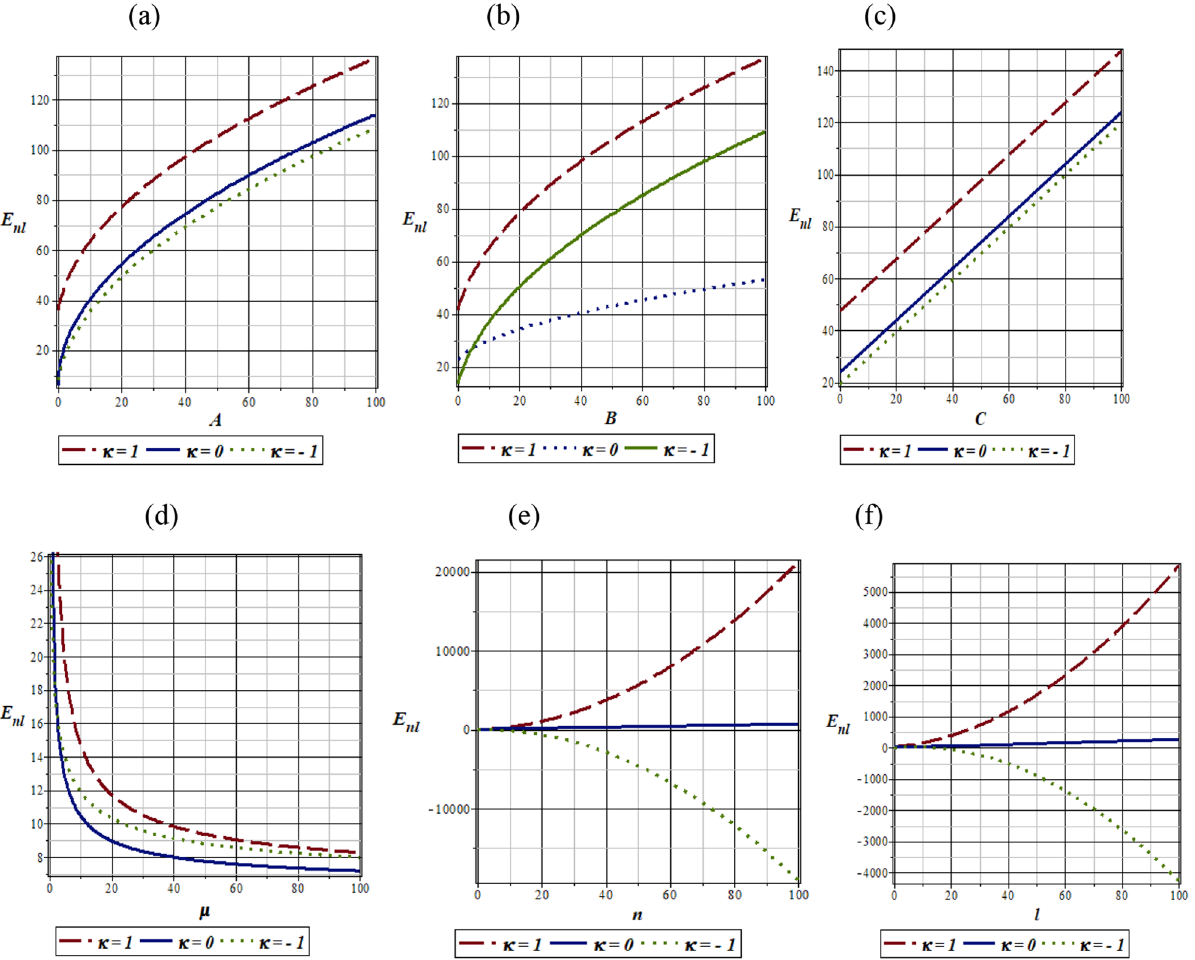
Figure 1. ( a ) Variation of energy eigenvalues of quantum pseudoharmonic oscillator with potential parameter ‘A’ for selected κ -values, ( b ) Variation of energy eigenvalues of quantum pseudoharmonic oscillator with potential parameter ‘B’ for selected κ -values, ( c ) Variation of energy eigenvalues of quantum pseudoharmonic oscillator with potential parameter ‘C’ for selected κ -values, ( d ) Variation of energy eigenvalues of quantum pseudoharmonic oscillator with reduced mass ′ µ ′ for selected κ -values, ( e ) Variation of energy eigenvalues of quantum pseudoharmonic oscillator with radial quantum number ‘ n ’ for selected κ -values, ( f )Variation of energy eigenvalues of quantum pseudoharmonic oscillator with orbital quantum number ‘l’ for selected κ